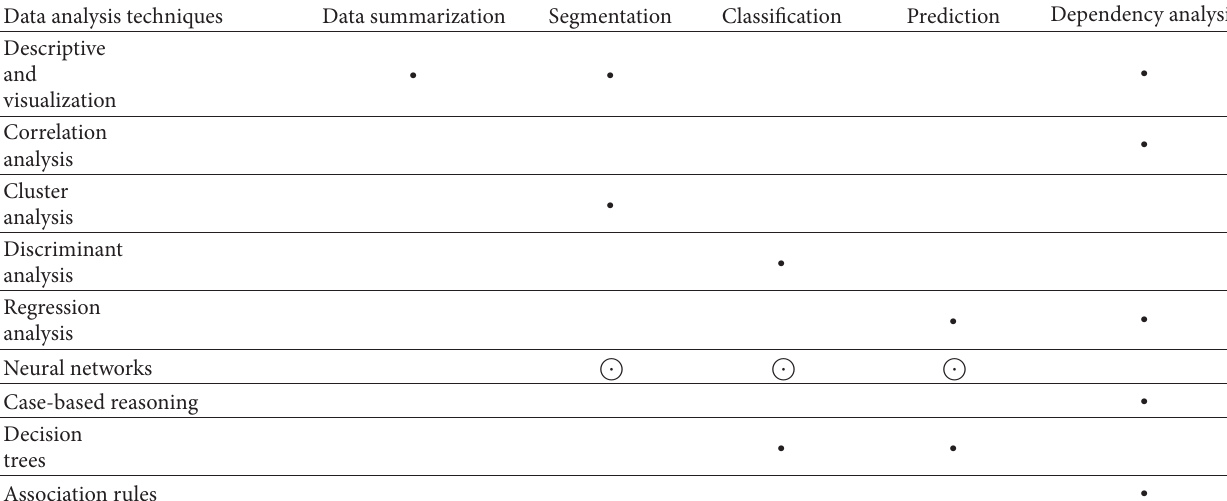
Table 1: Data analysis task and techniques